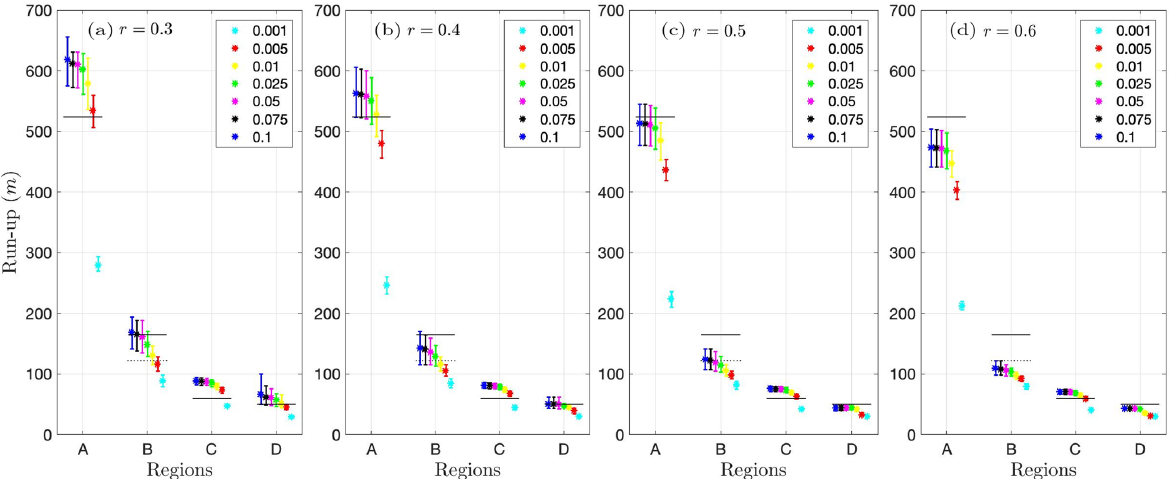
Figure 9. For a fixed value of the ratio of densities, r (in (a) r = 0 . 3; (b) r = 0 . 4; (c) r = 0 . 5; and (d) r = 0 . 6), the maximum computed run-up in the four regions defined in Fig. 6 for different values of the friction coefficient, m f (in different colors; see legend), is presented. The vertical bars show the run-up variation for values of α ranging from 8 to 16 ◦ .